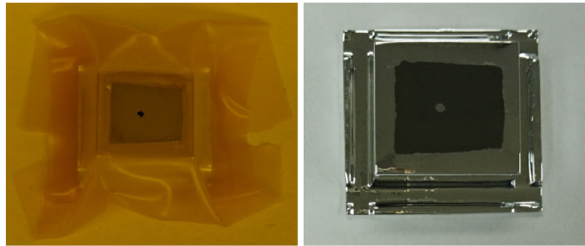
Fig. 5 Left: the detector was covered with acid resistant tape and paint (picine) to form the outer contact and point contact, respectively. Right: the top view of the completed planar PPC Ge detector, USD-W06. The uneven edgeoftheoutercontactwascausedbycuttingtheacidresistant tape manually